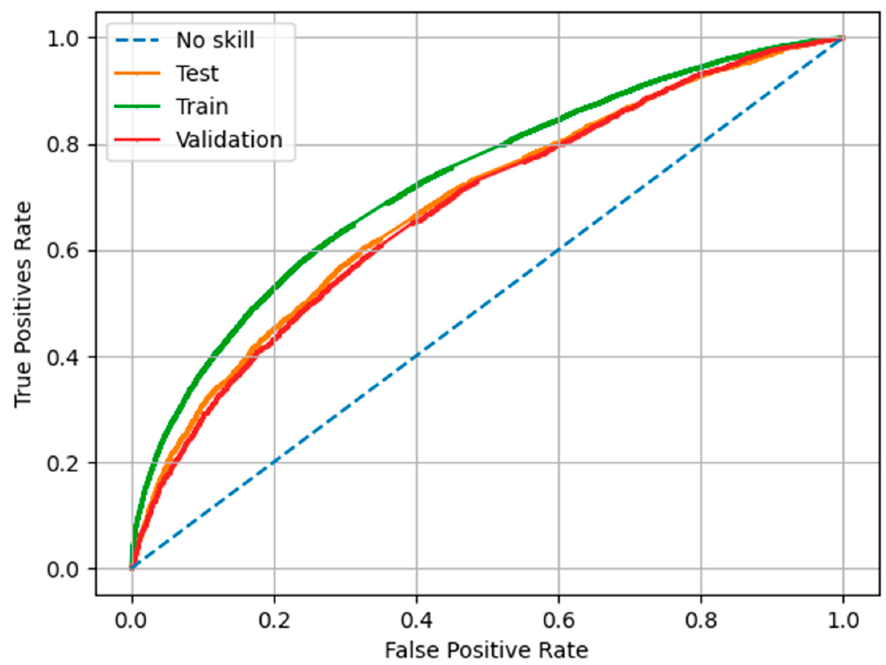
Figure 9. ROC-Curve—Results with Temperature.